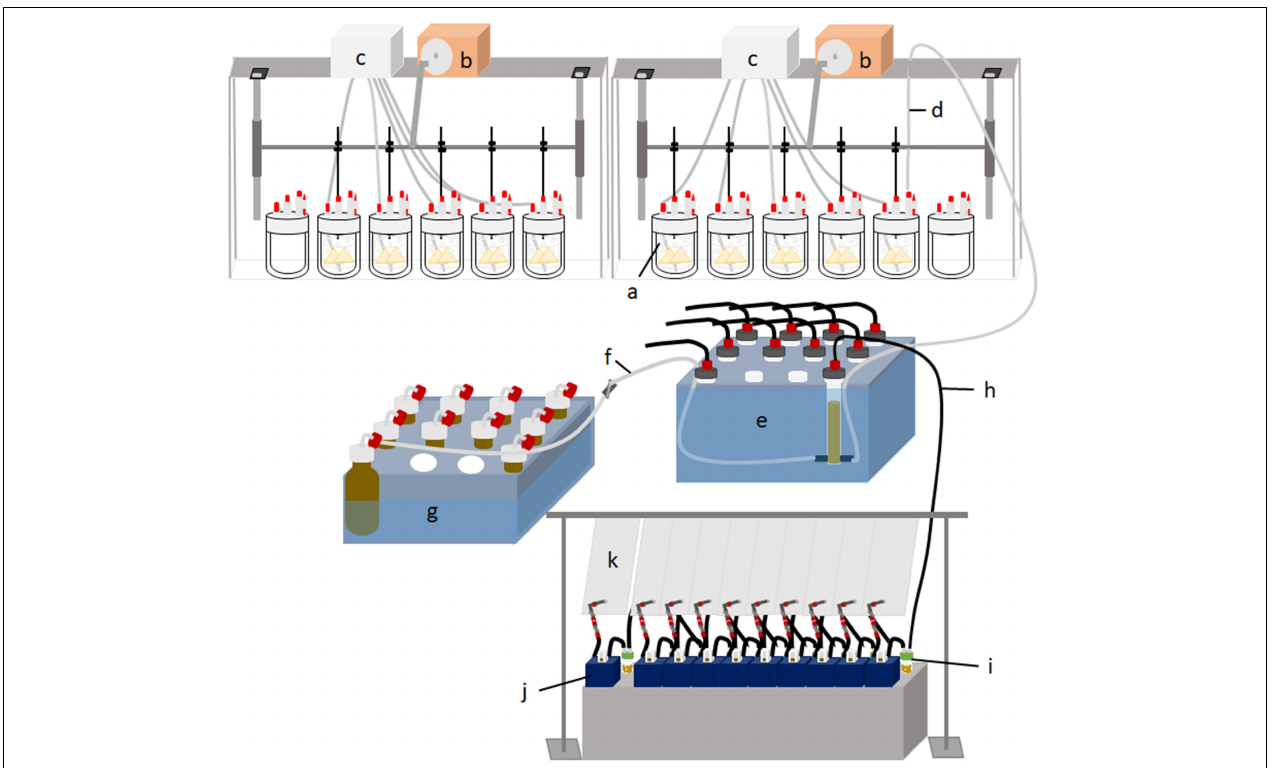
FIGURE 1 | Schematic diagram of the Rusitec set up with the 12 fermenters (a) connected to a lift motor (b), a buffer pump (c), and a gas-tight tube for the effluent (d). The effluent is separated in glass cylinders in a cooling water bath (e) into fluid effluent (f), which is collected in glass bottles in a cooling water bath (g), and gaseous effluent (h). The gaseous effluent is passed through a cold trap with an H 2 S absorber granulate (i), measured with gas counters (j), and sampled for methane analysis in plastic bags